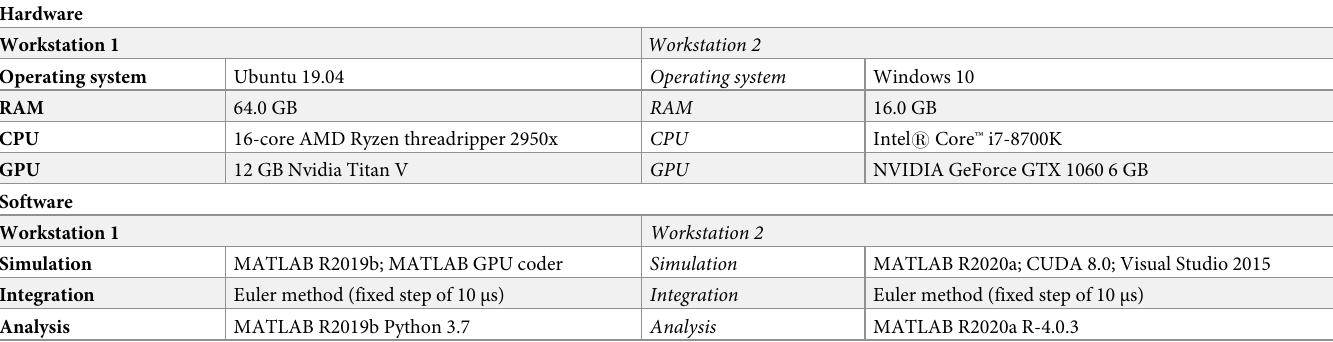
Table 1. Hardware and software specification for model reproducibility.